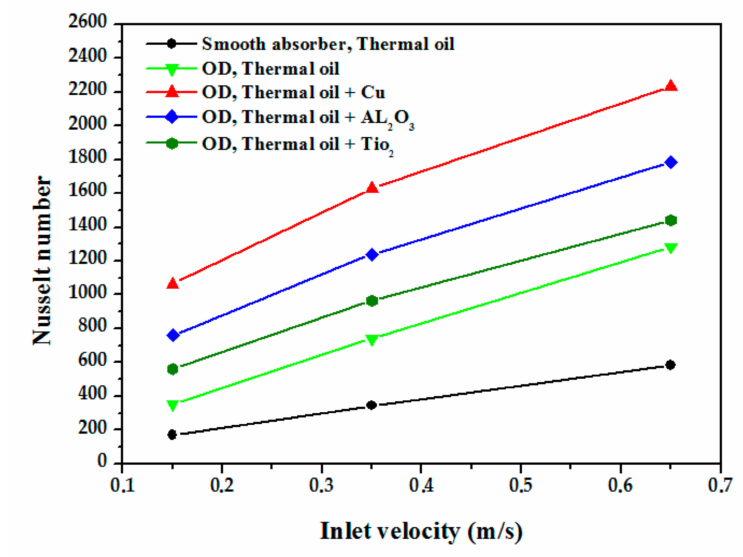
Figure 15. Nusselt number of cases examined for various inlet